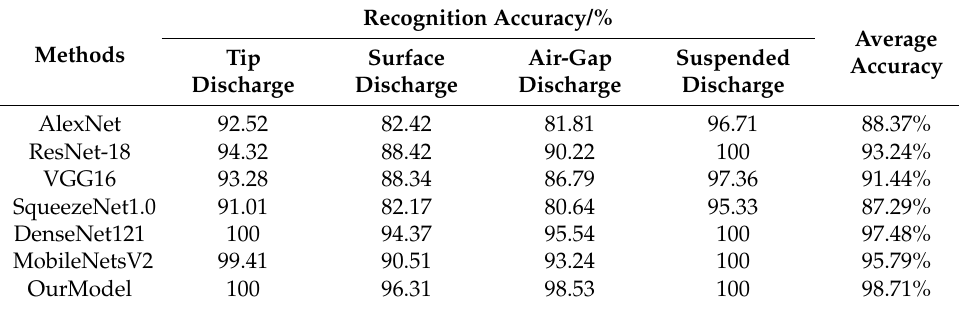
Table 3. Core module construction of